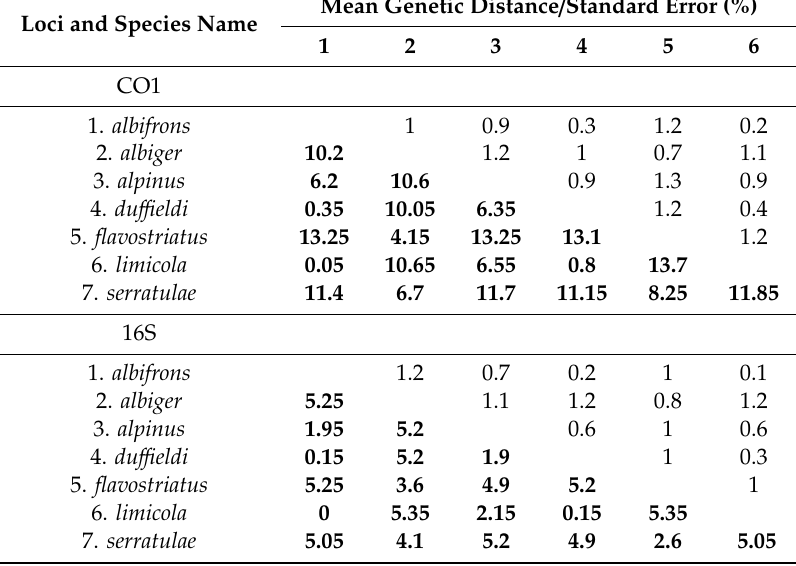
Table 5. Mean pairwise distances (%) (corrected for intra-specific distances) between Anoscopus taxa for CO1 and 16S in bold below each diagonal with standard error values (%) above (generated by MEGA v6.0; [56] Tamura et al., 2013). Anoscopus histrionicus was not included as there was only one individual